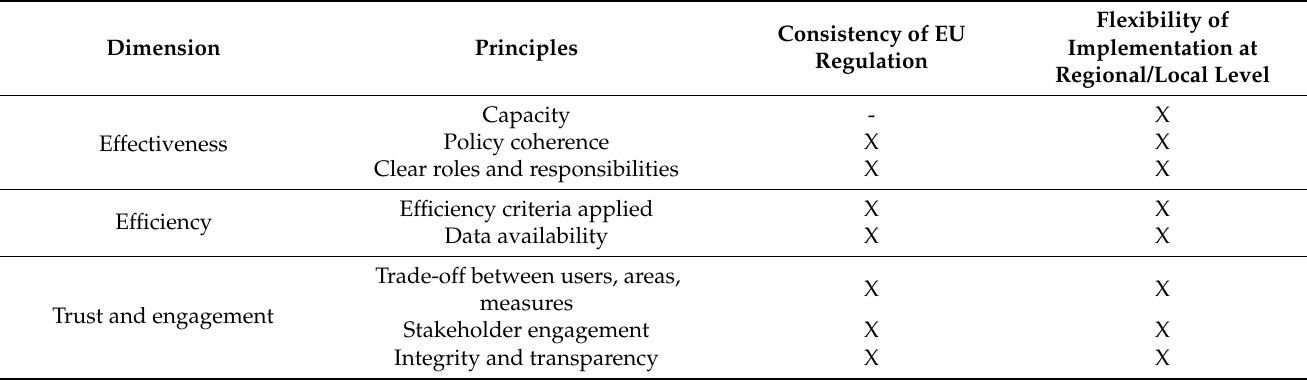
Table 1. EU rural development policy analysis